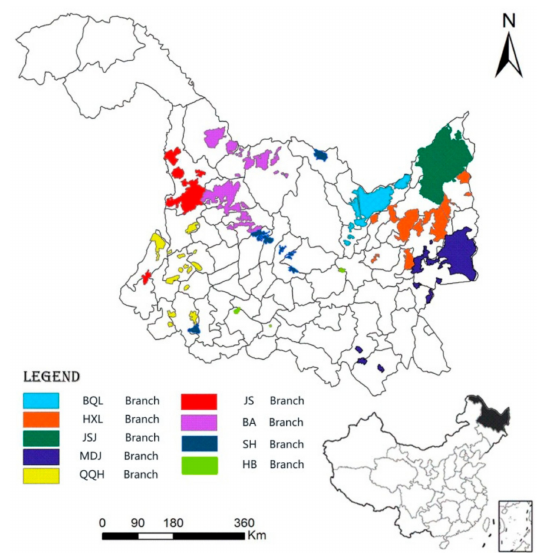
Figure 2. Location of the study area.